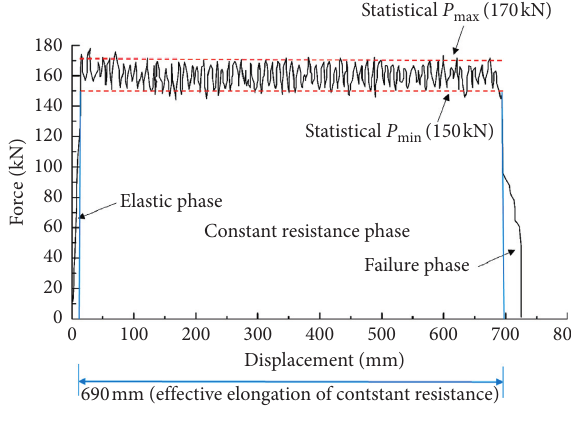
Figure 8: Static tension diagram of NPR bolt. Table 2: Physical and mechanical parameters of engineering-scale and model-scale bolts. Bolt